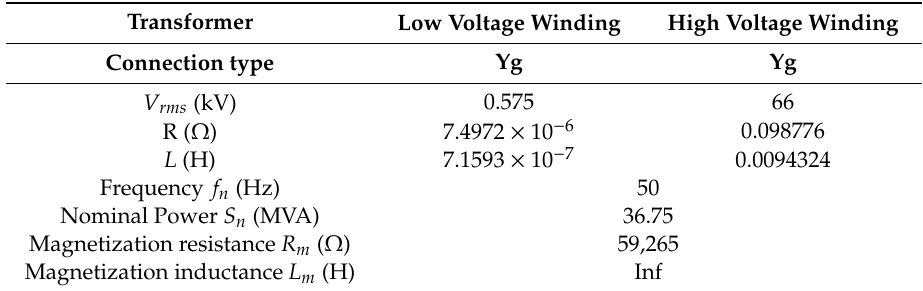
Table A3. Parameters of the three-phase 0.575 / 66 kV transformer of Wind farm A.